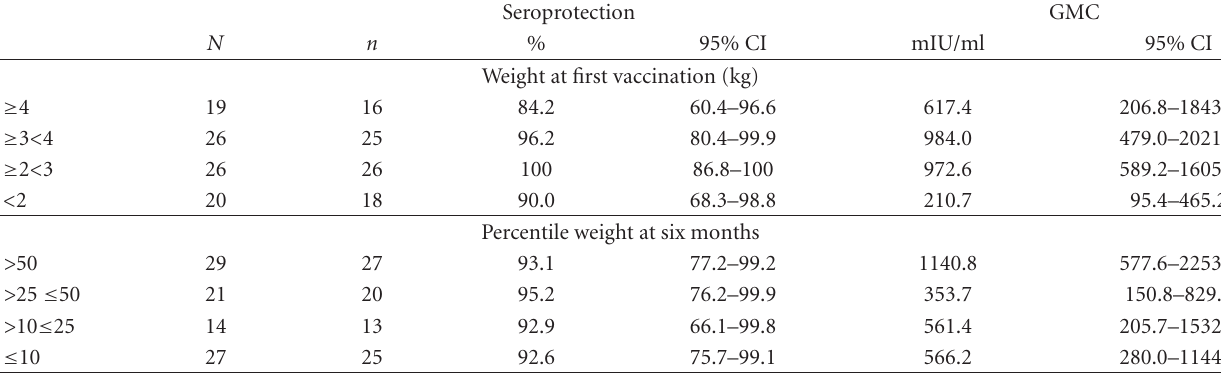
Table 4: Post-primary anti-HBs seroprotection rates and GMCs by weight at vaccination and percentile weight at six months (ATP cohort for immunogenicity).